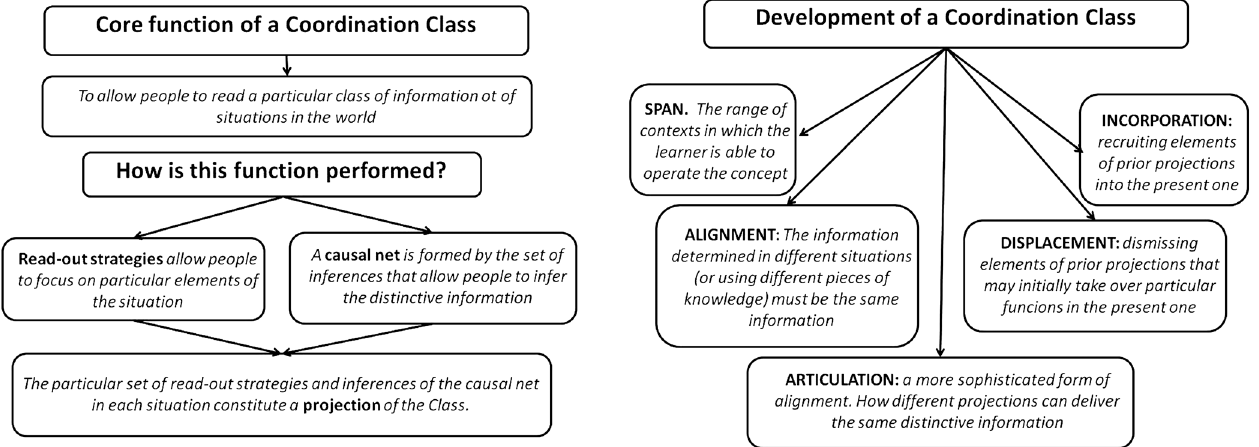
FIG. 2. Schematic representation of theoretical elements that constitute a coordination